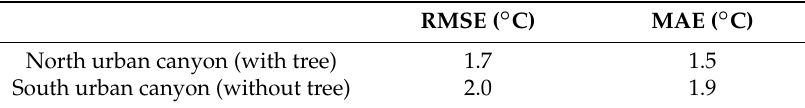
Table 4. Temperature measurement errors (root mean squared error (RMSE) and mean absolute error (MAE)) between the thermal images and iButton loggers.